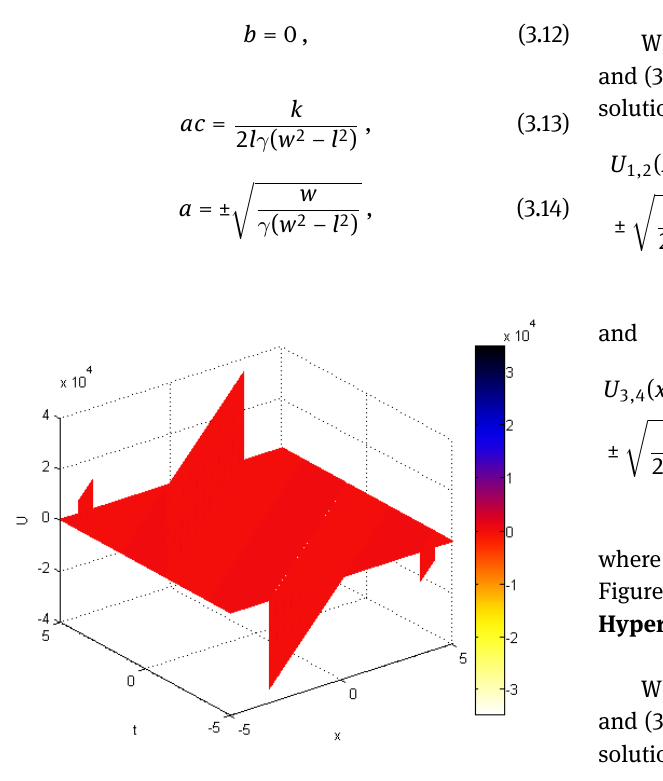
Fig. 1: The solution U 1 ( x , 0, t ) in (3.15) for l =1.5, k =1, a =1, µ =0, w = 2 and −5 ≤ t , x ≤ 5 .